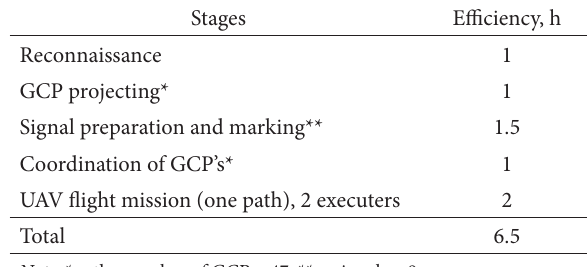
Table 2. Efficiency for the UAV flight mission